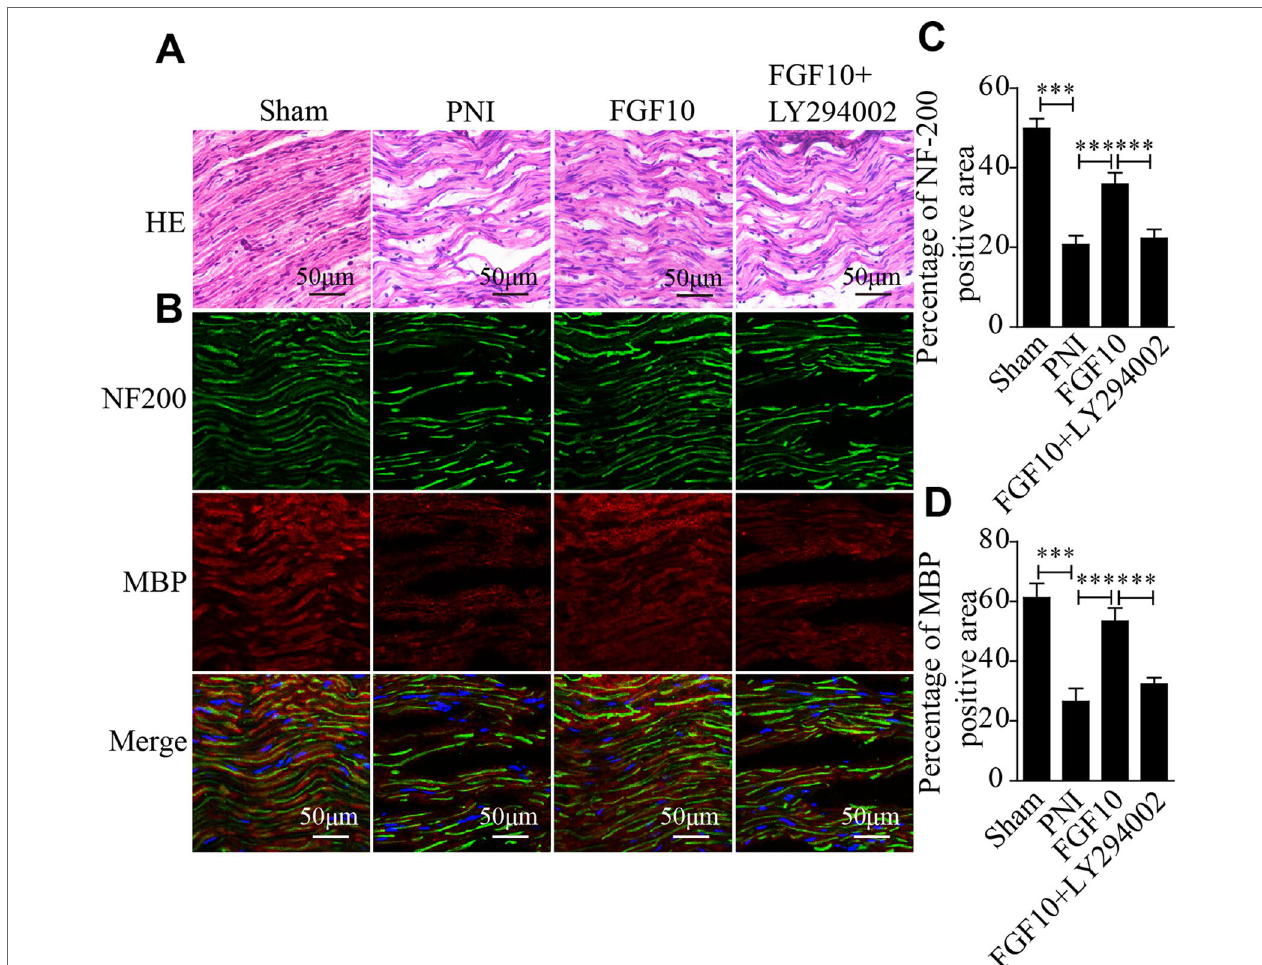
FIGURE 2 | Fibroblast growth factor 10 (FGF10) promotes axonal regeneration, as determined by histological evaluation. (A) Longitudinal sections of regenerated nerves from each group were stained with Hematoxylin-Eosin (HE) 28 days postinjury. Scale bars = 50 μm. (B) Immunofluorescence staining for myelin basic protein (MBP) (red) and NF-200 (green) in longitudinal sections. Scale bars = 50 μm. (C, D) Quantitative analysis of the fluorescence intensity of MBP and NF-200 28 days following injury. The data are presented as the mean ± SEM, n = 5. Sham group vs PNI group: *** P < 0.001. FGF10 group vs peripheral nerve injury (PNI) group: *** P < 0.001. FGF10 group vs FGF10+LY294002 group: *** P <